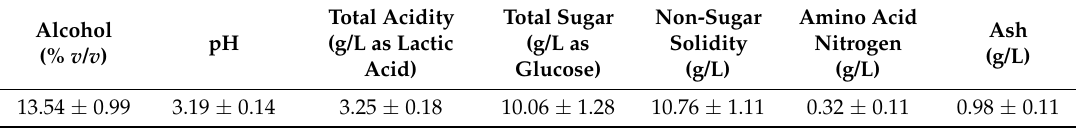
Table 2. General composition of the foxtail millet sake (n ±